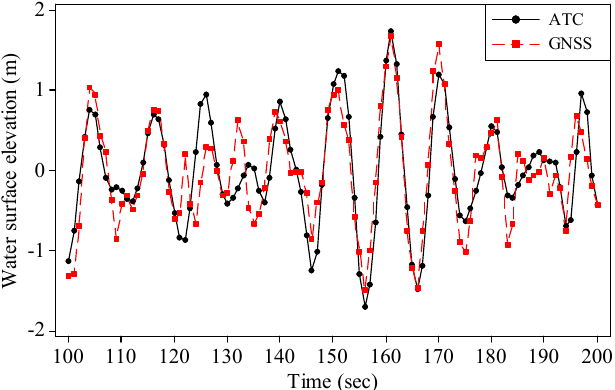
Figure 7. Water surface elevations obtained from the ATC sensor and GNSS receiver at 09:00 on 21 August 2013.